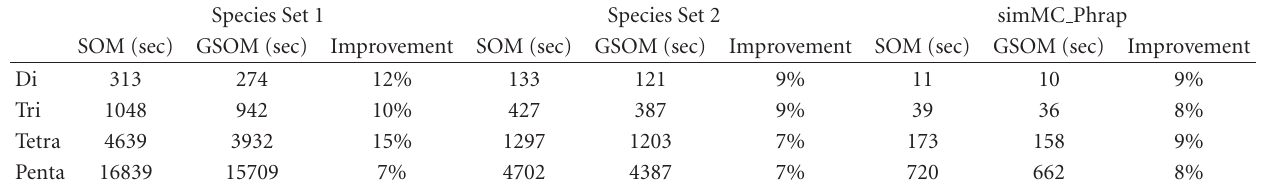
Table 7: Speed comparisons for the overall training time of SOM and GSOM, in which the improvement columns represent the percentage of speed improvement for GSOM comparing to